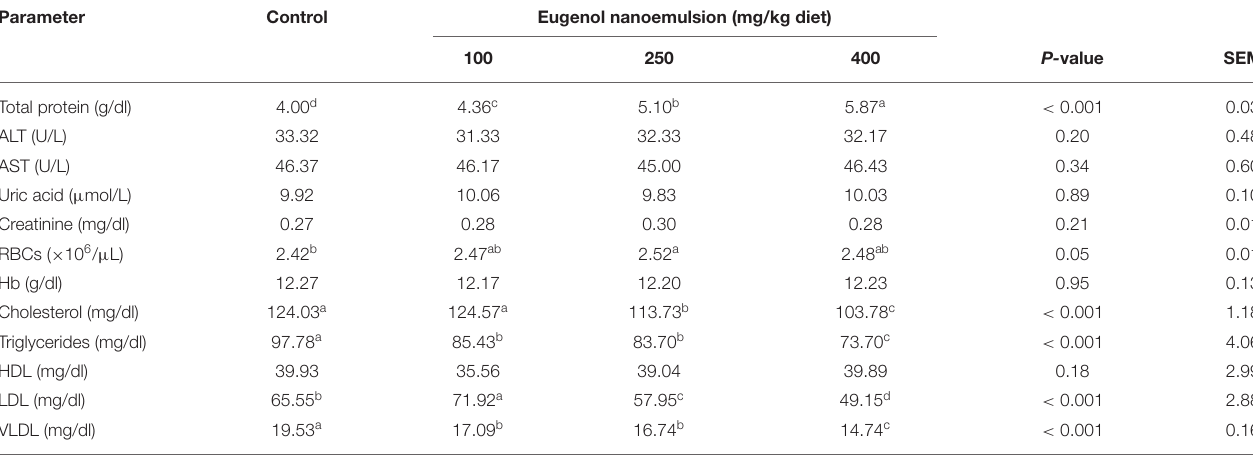
TABLE 4 | Effects of dietary supplementation of different doses of eugenol nanoemulsion on serum biochemical parameters of broilers prior to E. coli O78 challenge. Parameter Control